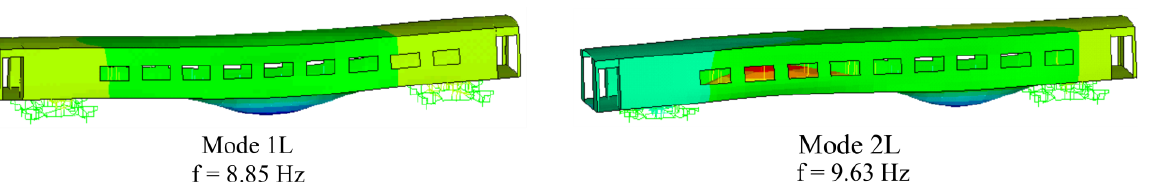
Figure 5. Numerically obtained local vibration modes of the housing.